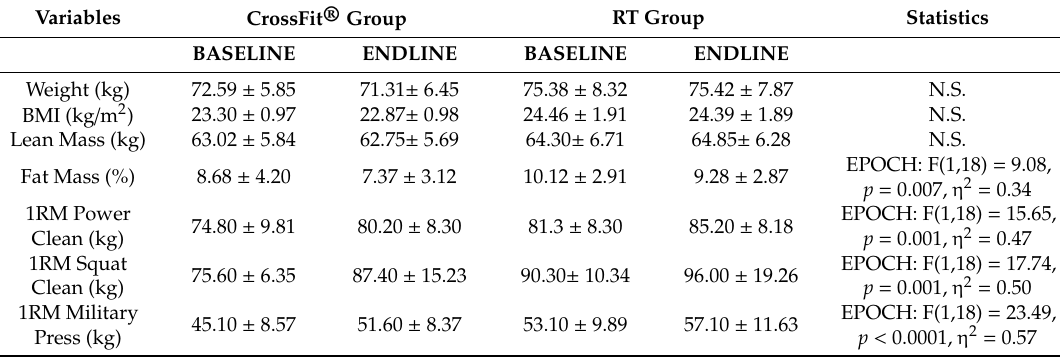
Table 2. Participants’ anthropometric characteristics and results of testing procedures before and after the training regimes (mean ± SD).